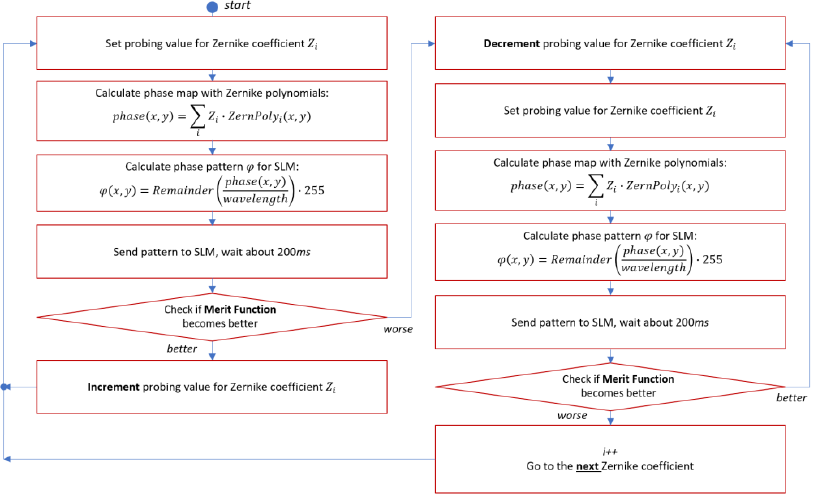
Figure 6. Flow map of the algorithm used to focus a scattered laser beam with the spatial light modulator.